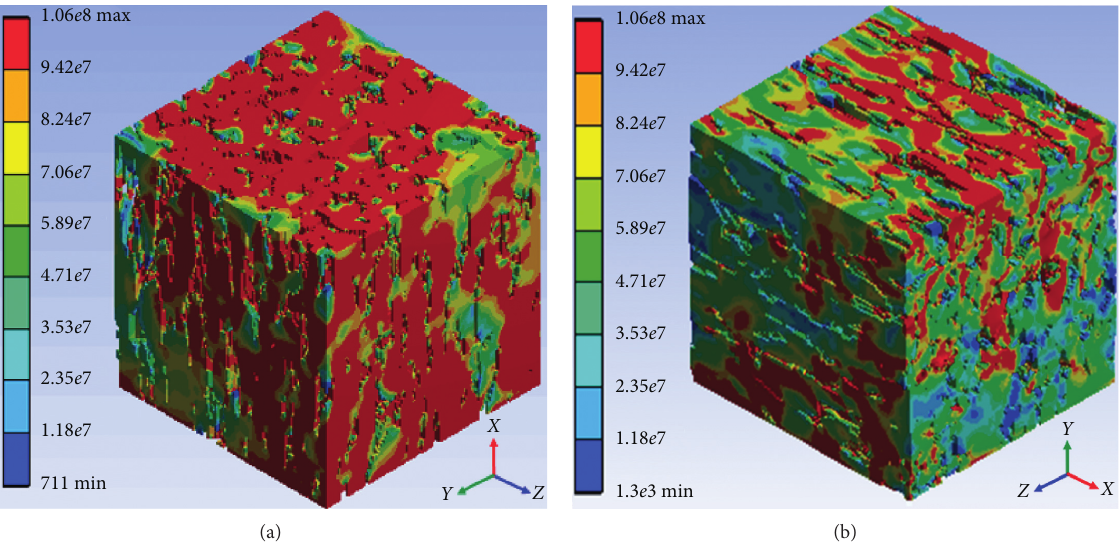
Figure 6: Averaged von Mises stress distribution of model S2 (unit: Pa) represents the loading applied (a) in X direction and (b) in Y